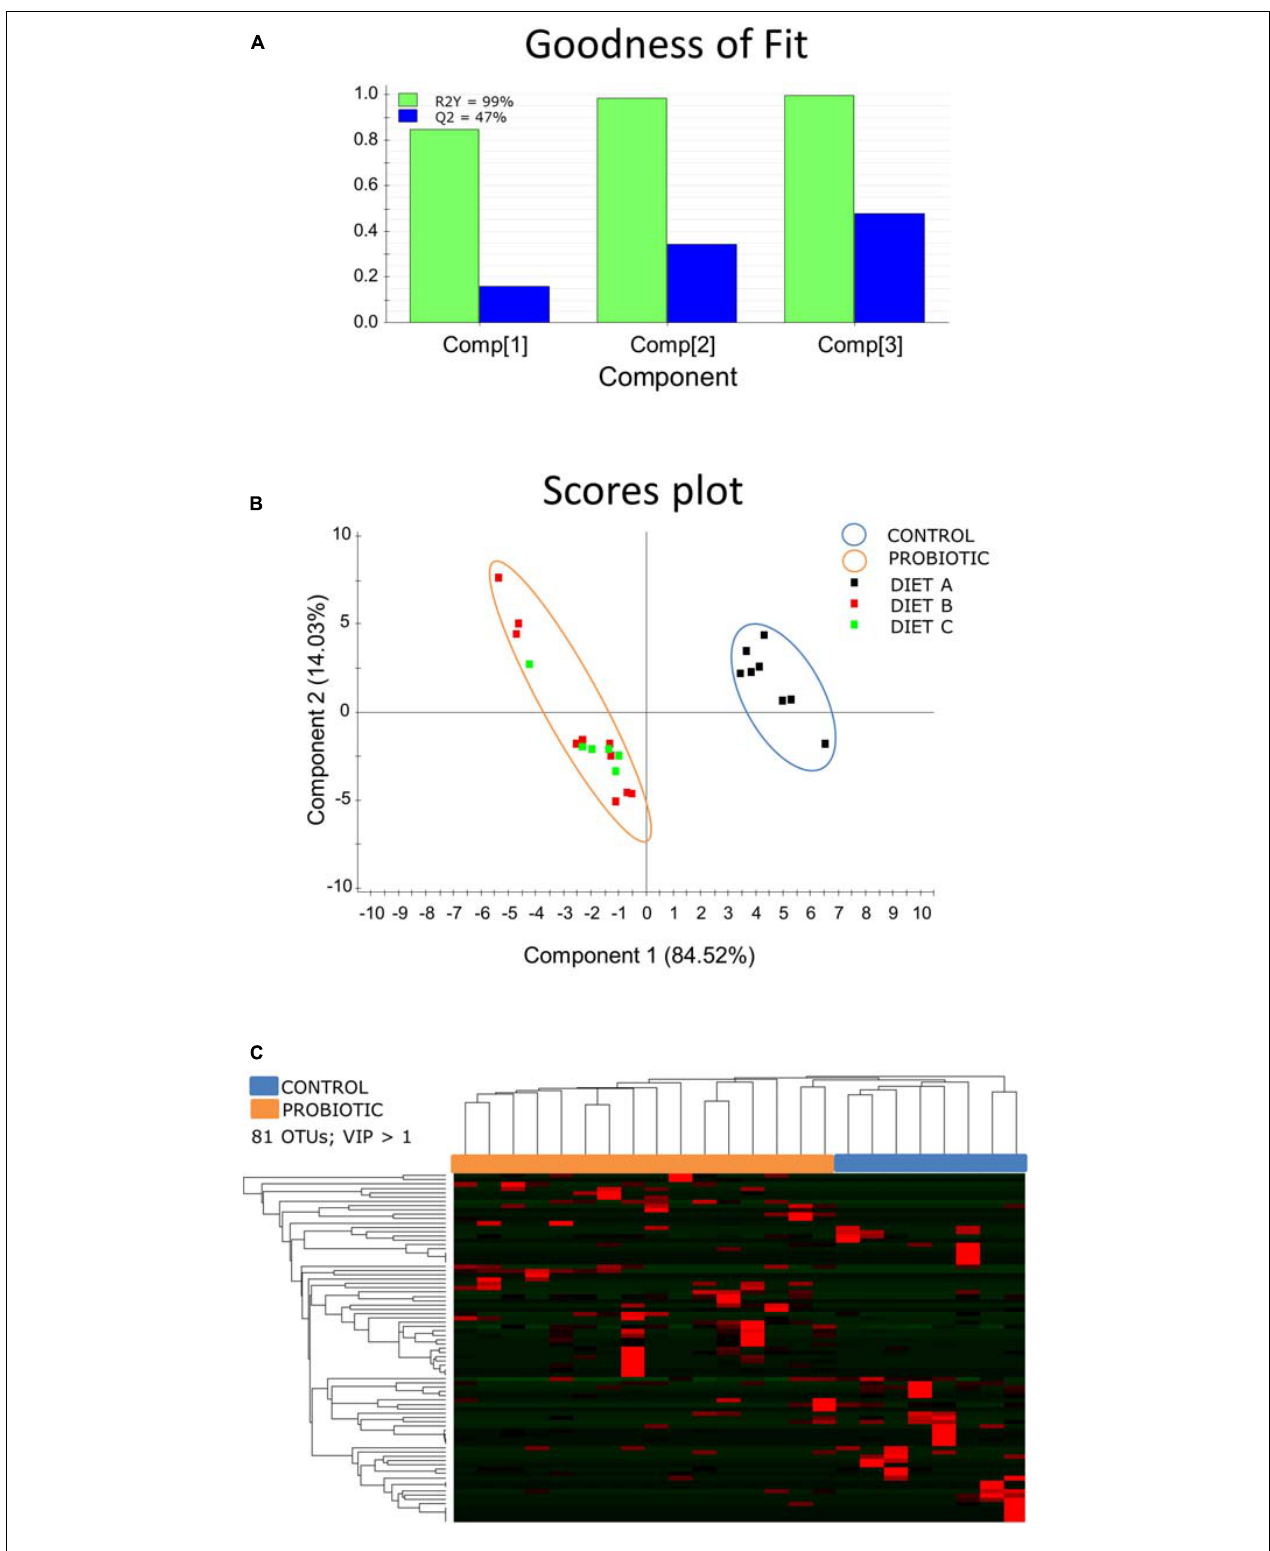
FIGURE 5 | (A) Graphical representation of the goodness-of-fit of the PLS-DA model. (B) Two-dimensional PLS-DA score plot representing the distribution of the samples between the first two components in the model. (C) Heatmap showing the abundance distribution ( z -score) of the OTUs identified to be driving the separation between fish fed probiotic diets (B + C; orange) and fish fed diet A (blue).